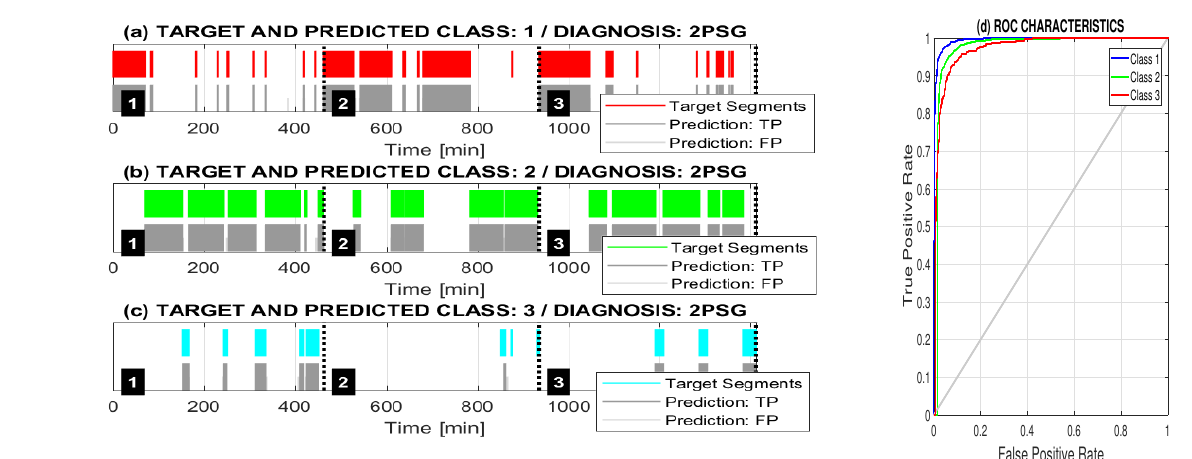
Figure 7. Target and predicted classes of three selected patients with sleep apnea classified by the adaptive neural network model into three classes including ( a ) class 1 (Wake); ( b ) class 2 (NonREM); and ( c ) class 3 (REM) together with ( d ) associated ROC characteristics.